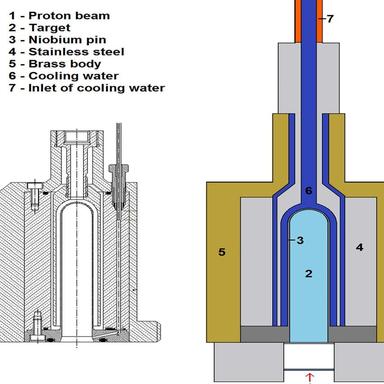
Calculation model of the used target in iron shielding (right) and a detailed view of the target design in the vertical plane (left)